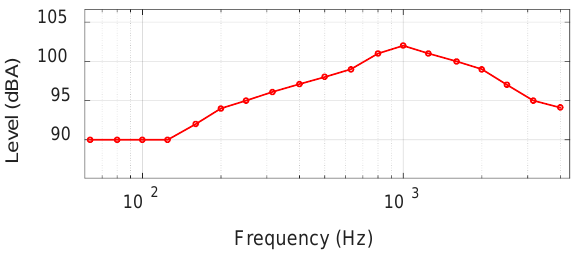
Figure 1. A-weighted sound power level (Lw) spectrum. Road traffic noise spectrum according to [38].